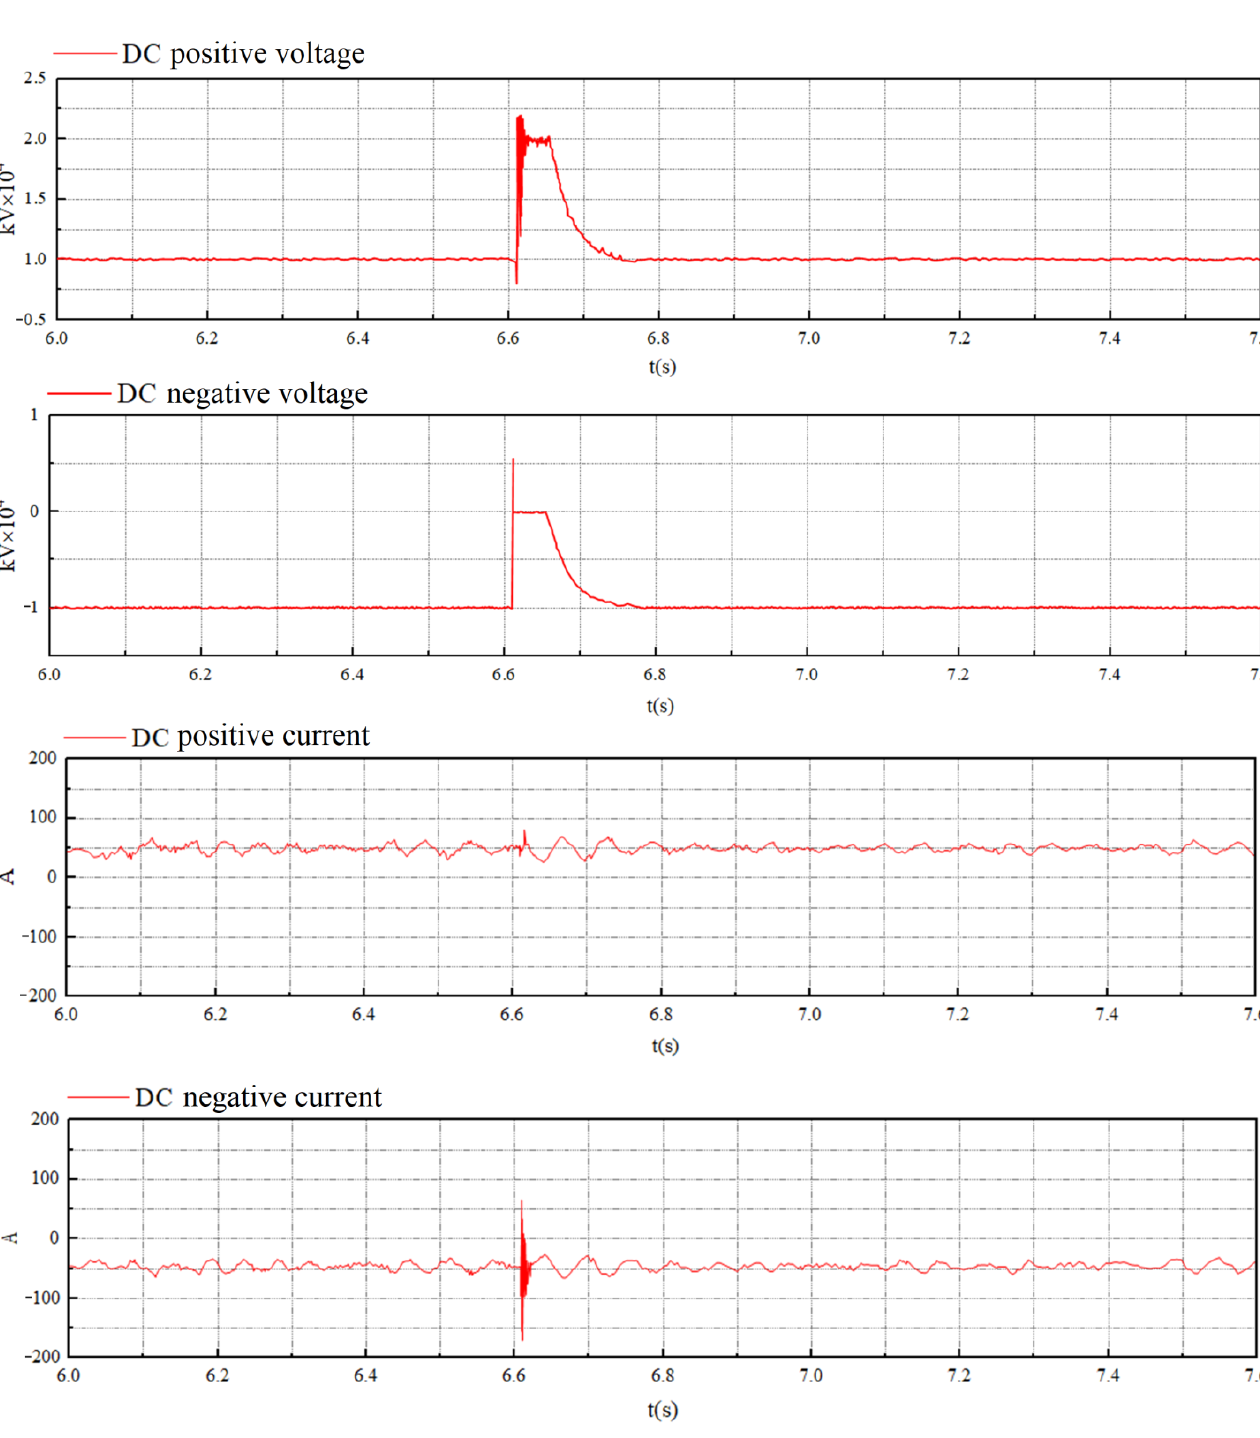
Figure 8. Waveforms of T2.